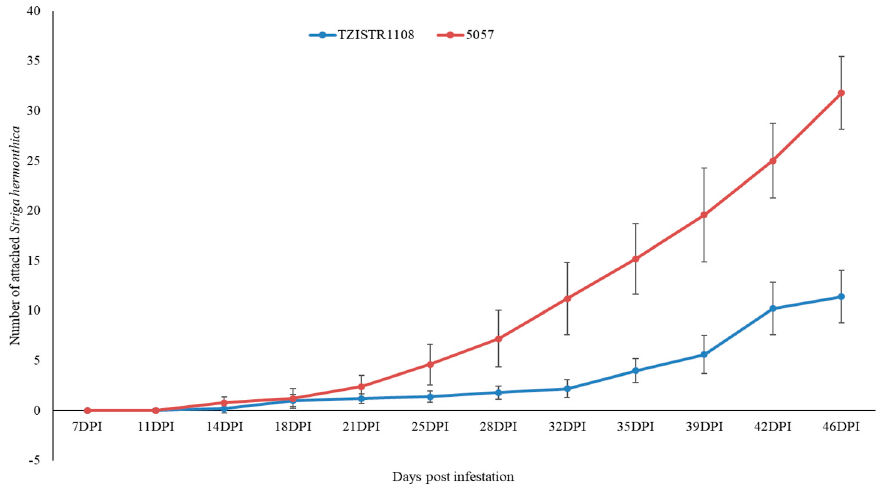
Figure 4. Mean number of attached Striga hermonthica plants on resistant (TZISTR1108) and susceptible (5057) maize lines in group A (No GR24 treatment) as the experiment progressed. Error bars show Standard error.